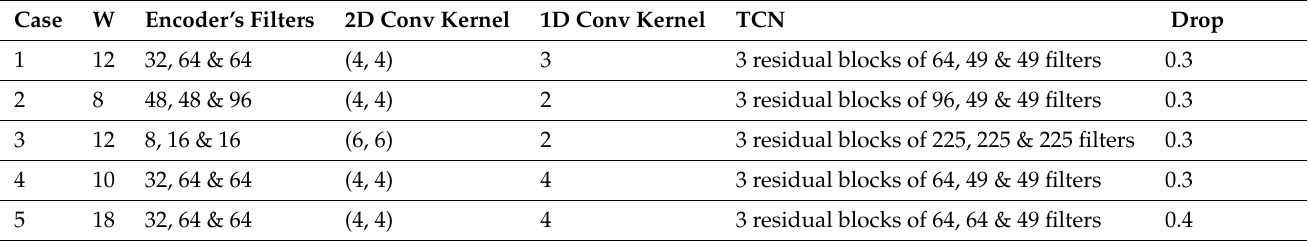
Table 1. Table to show the hyperparameters that were chosen for the E-TCN for each of the experi- ments. W represents the hyperparameter timesteps and Drop., the dropout rate. The third column shows the number of filters at the three 2D convolutional layers in the encoder